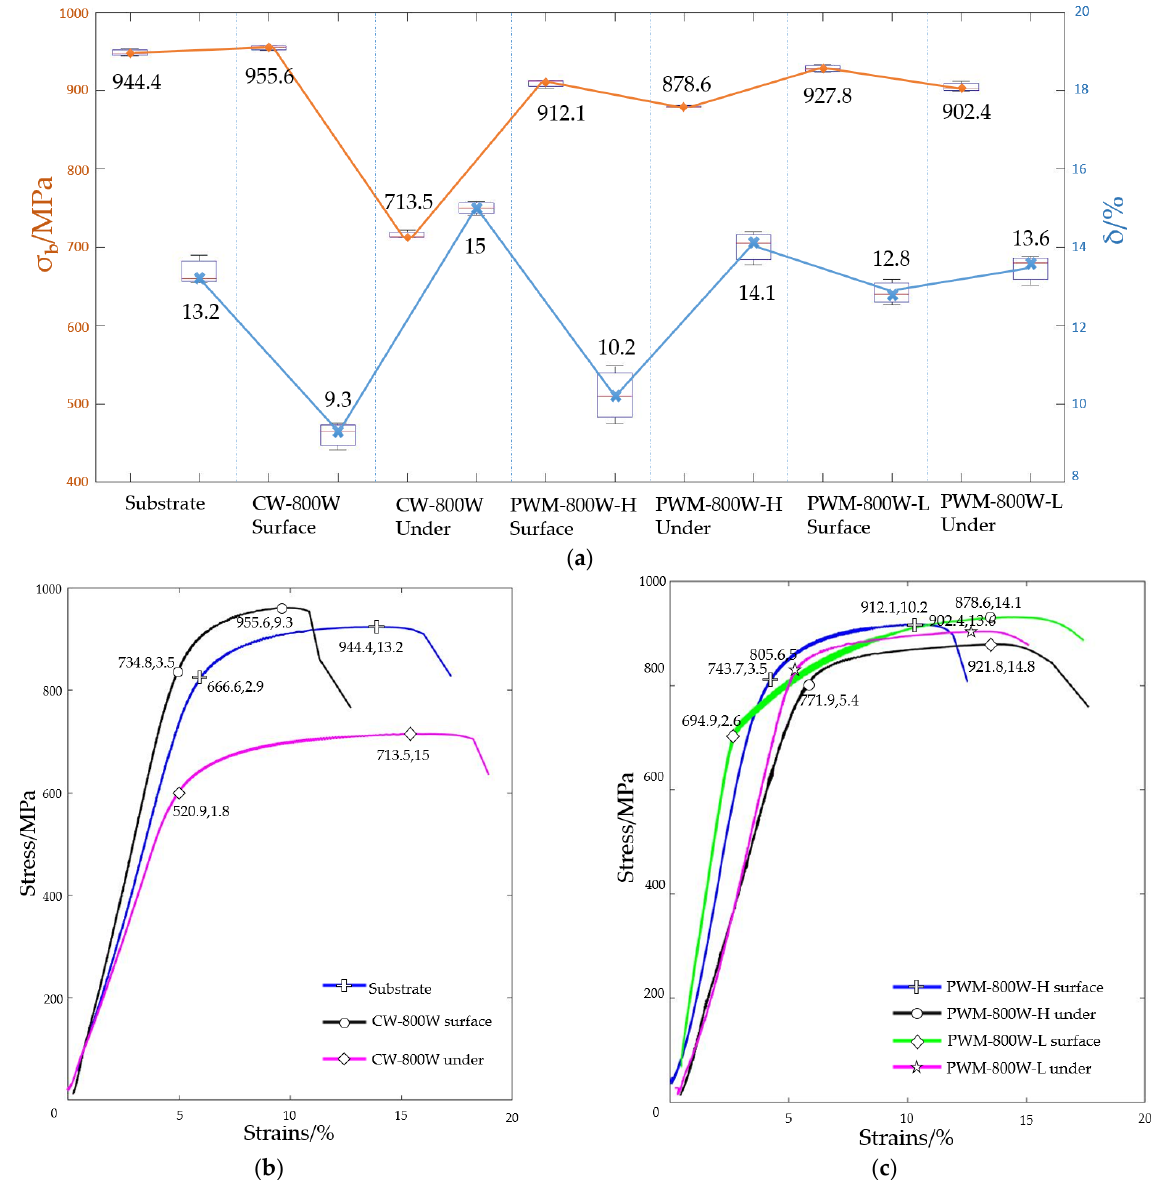
Figure 5. Tensile properties: ( a ) Box drawing of strength and elongation under different processes; ( b ) stress ‐ strain curves of substrate, CW ‐ 800W surface, and under CW ‐ 800W surface; ( c ) stress ‐ strain curves of the PWM ‐ 800 ‐ H surface, under the PWM ‐ 800 ‐ H surface, the PWM ‐ 800 ‐ L surface, and under PWM ‐ 800 ‐ L.